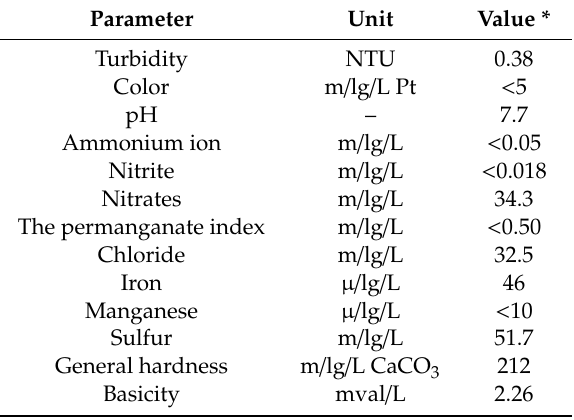
Table 2. Tap water characteristics in city of Częstochowa .